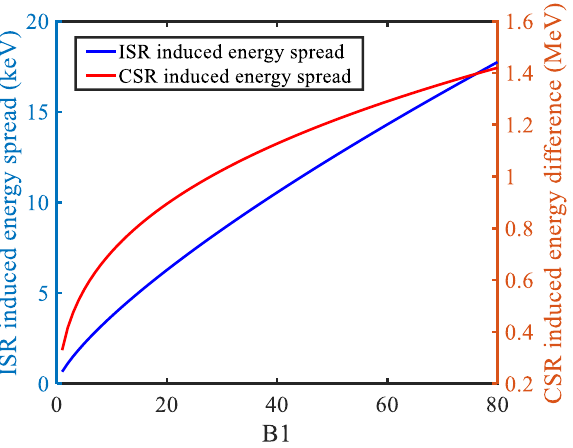
Figure 7. The incoherent synchrotron radiation (ISR) induced energy spread (left coordinate, blue) and coherent synchrotron radiation (CSR) induced energy difference (right coordinate, red) as functions of the dispersion strength of chicane 1.